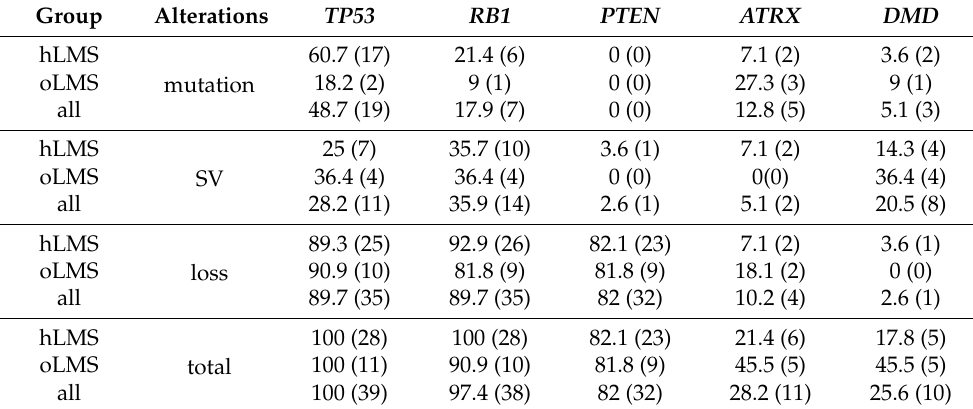
Table 2. Summary of genetic alterations in 39 ICGC patients for TP53 , RB1 , PTEN , ATRX and DMD . Alterations are categorized as follows: mutation: missense, nonsense, frameshift (FS), non-FS, splicing, SV: structural variant, loss: loss of at least one allele, total: number of patients carrying at least one alteration. Numbers indicate the percentage of patients harboring the alteration; the actual numbers are reported between